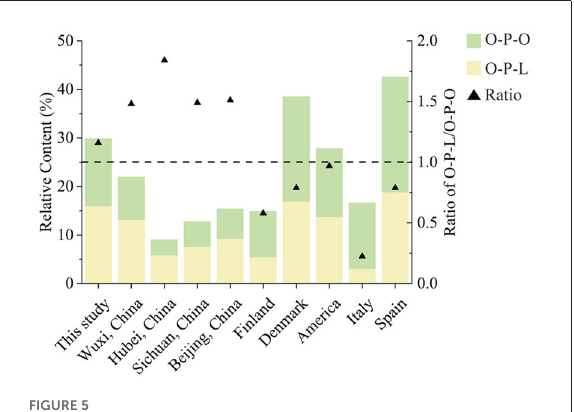
FIGURE5 The contents of O-P-L, O-P-O, and the ratio of O-P-L to O-P-O in human milk from different countries.